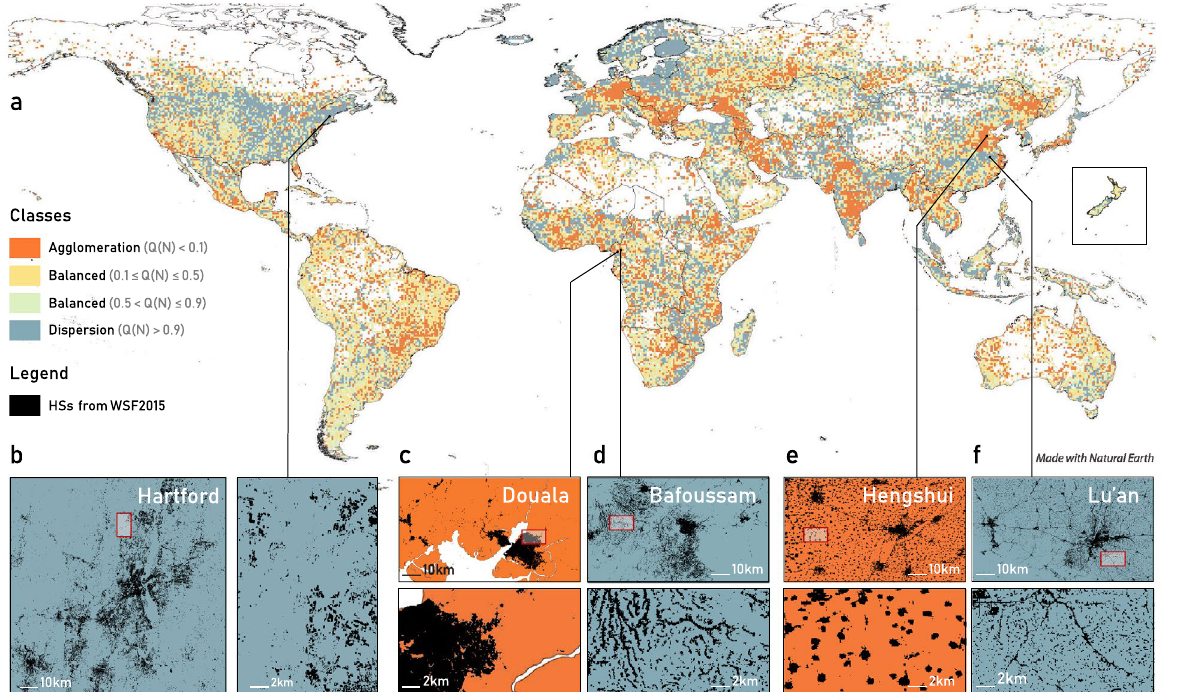
Figure 4. Global classification of the HS patterns by their deviation from the urban scaling predictions. The colour range is consistent across all panels. The blue insets ( b , d , f ) show the dispersion class, which represents locations with more HSs than expected from the scaling theory. ( b ) Two different zoom levels of Hartford’s metropolitan area (USA), where urban dispersion is due to extensive patterns of single housing and car-centric transportation. ( d ) Urban-rural agglomeration in the area around Bafoussam (Cameroon), where settlements are mostly composed of informal single housing/agricultural units. ( f ) Area around Lu’an (China), where there is an abundance of low-density sparse and small settlements. The orange insets ( c , e ) show the agglomeration class, in which we find fewer settlements than expected. ( c ) The city of Douala (Cameroon), where urbanization occurs tightly around the existing urban core. ( e ) The area around the city of Hengshui (China), where the many small settlements are most likely due to the agricultural land preservation strategies that have been extensively developed with a focus on compactness. In each 10 km pattern inset, we highlight with a red box the area showed by the 2 km zoom A spatial model for human settlements.